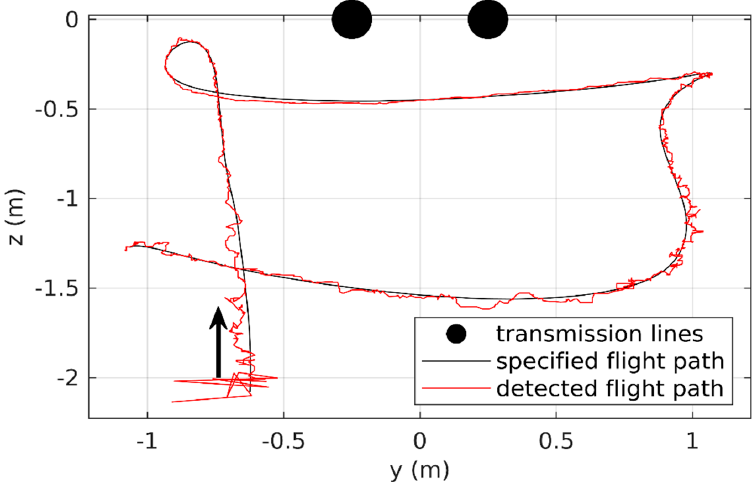
Figure 15. Localization quality in the case of low transmission line current of 100 A, four sensors, σ = 1 μ